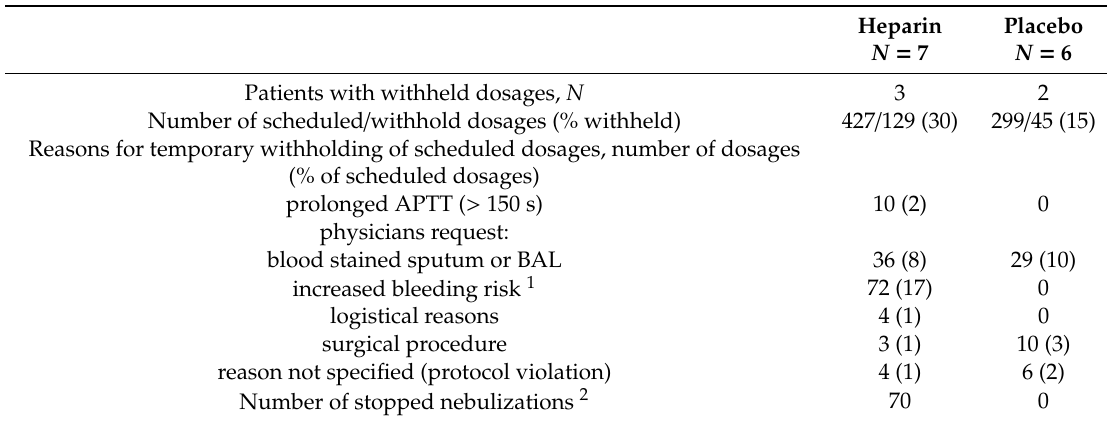
Table 2. Feasibility and reasons to withheld